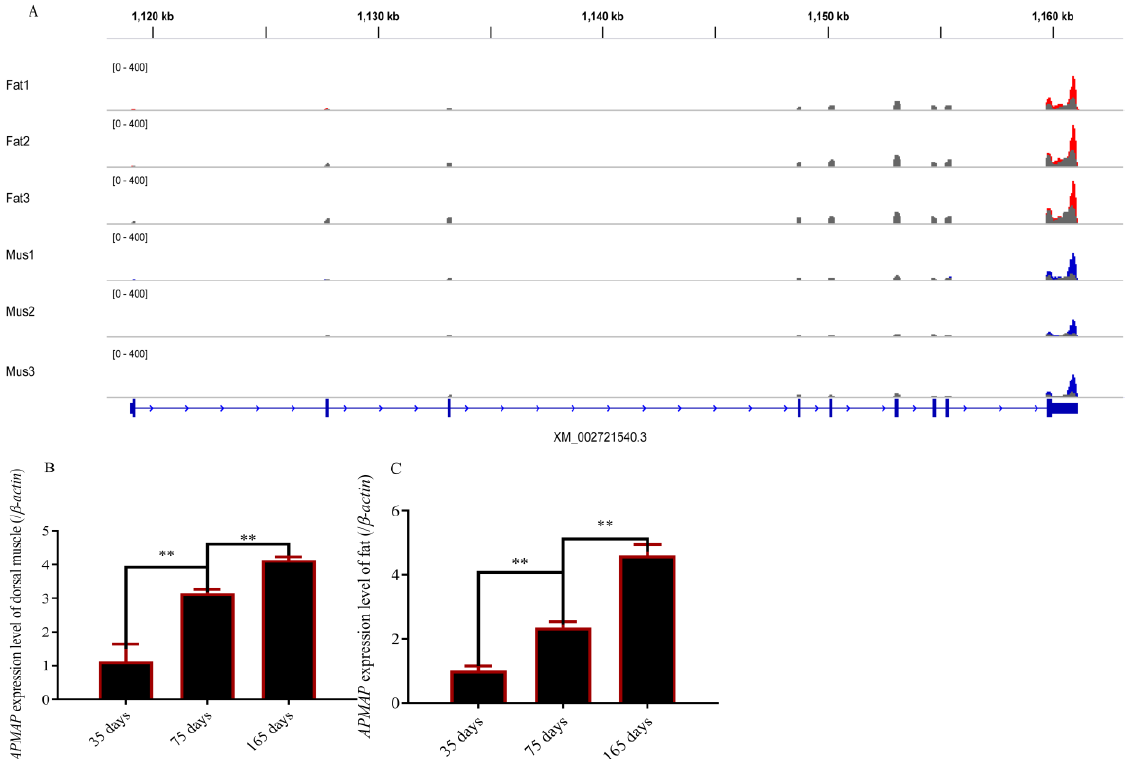
Figure 1. Methylation modification and APMAP expression in muscle and fat tissues. ( A ) Examples of dynamic methylated with m 6 A peaks in APMAP gene (According to our m 6 A sequencing data and we selected an m 6 A modified gene from them. The article was published in Biology journal [28]. This figure does not exist in the published article. This figure only plays the role of leading out the research in this paper.); ( B ) APMAP expression in dorsal muscles at 35, 75, and 165 days of age; ( C ) APMAP expression in fat tissues at 35, 75, and 165 days of age ( ** p ≤ 0.01).